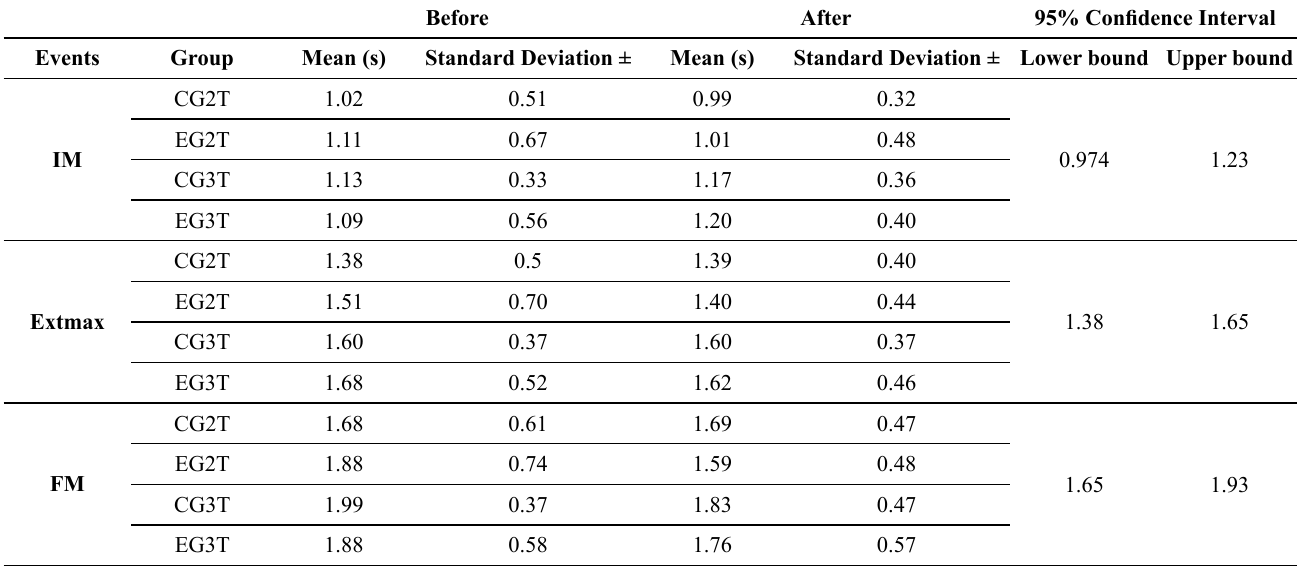
Table 2. Comparison of the occurrence instant of STS events considering the two moments of evaluation between the analyzed groups Before After 95% Confidence Interval Events Group Mean (s) Standard Deviation ± Mean (s) Standard Deviation ± Lower bound Upper bound